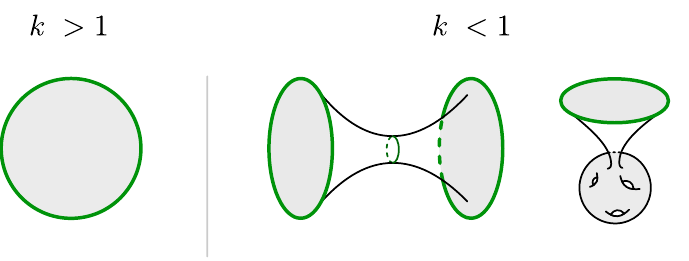
Figure 4 . Summary of the classical Euclidean geometries for fixed K and g uu boundary conditions. For k > 1 we can have a smooth bulk geometry, the disk. For k < 1 the geometry is cylindrical and we have drawn (in slightly darker green) another fixed K and g cutting the geometry there gives the trumpet